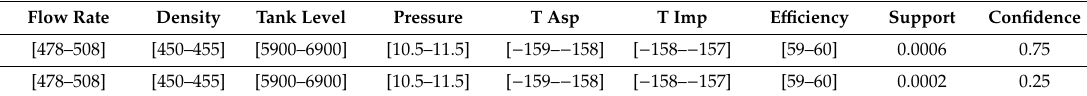
Table 9. Example of the ARs extracted.